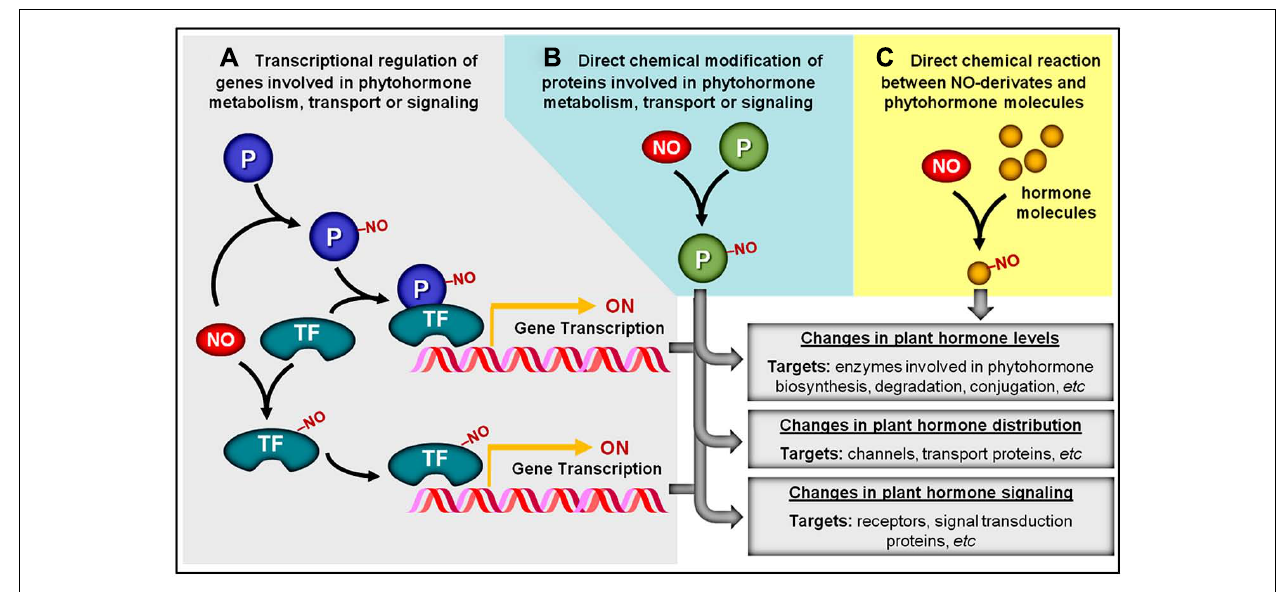
FIGURE 2 | Overview of potential NO–phytohormone interaction mechanisms. (A) By chemically modifying transcription factors (TF) and other proteins (P), NO may influence the transcription level of genes involved in phytohormone metabolism, transport, or signal transduction. (B) NO may post-translationally modify proteins (P) directly involved in